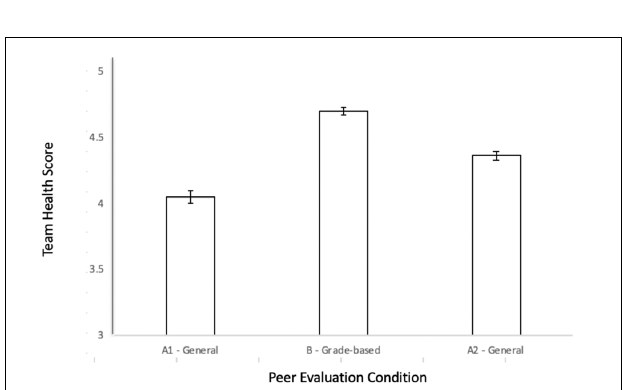
FIGURE 1 | Peer evaluation scores across conditions. Error bars represent 95% confidence intervals.